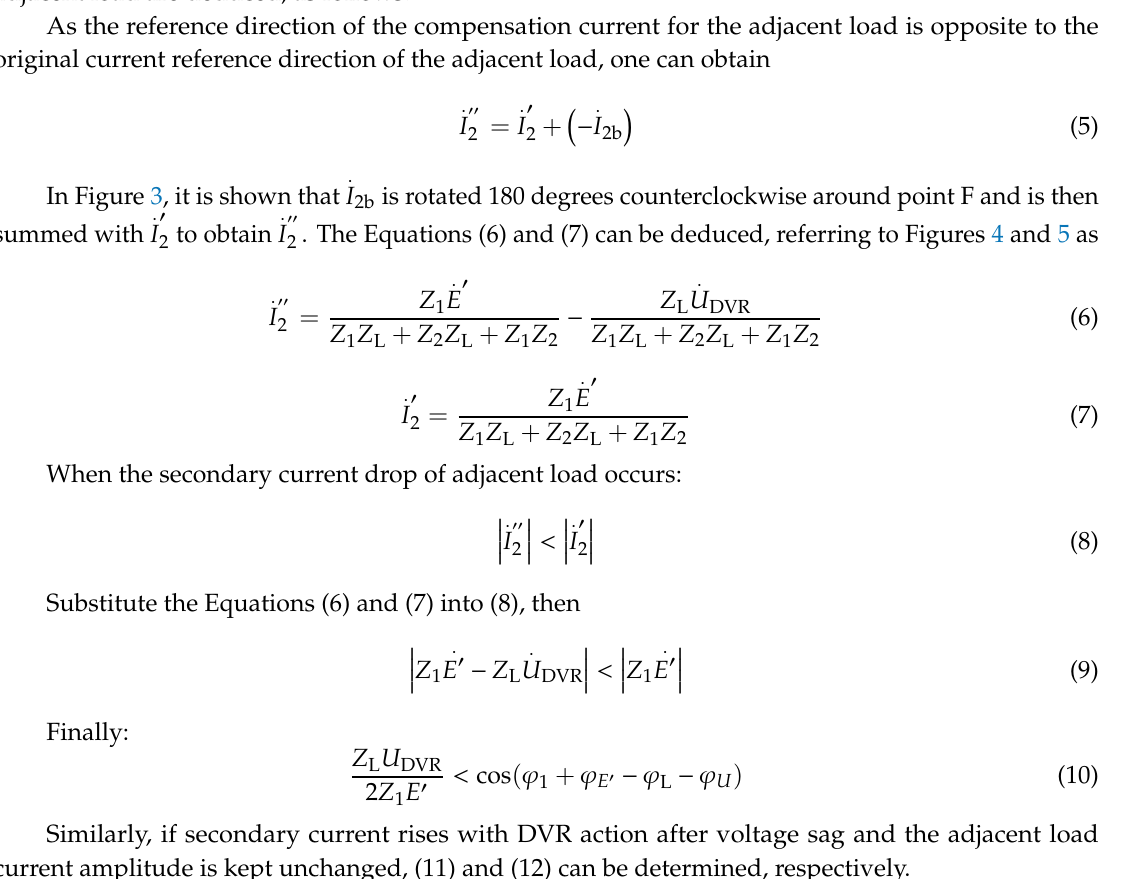
Figure 6. Phasor diagram of the influence of DVR on the adjacent load current when Z 1